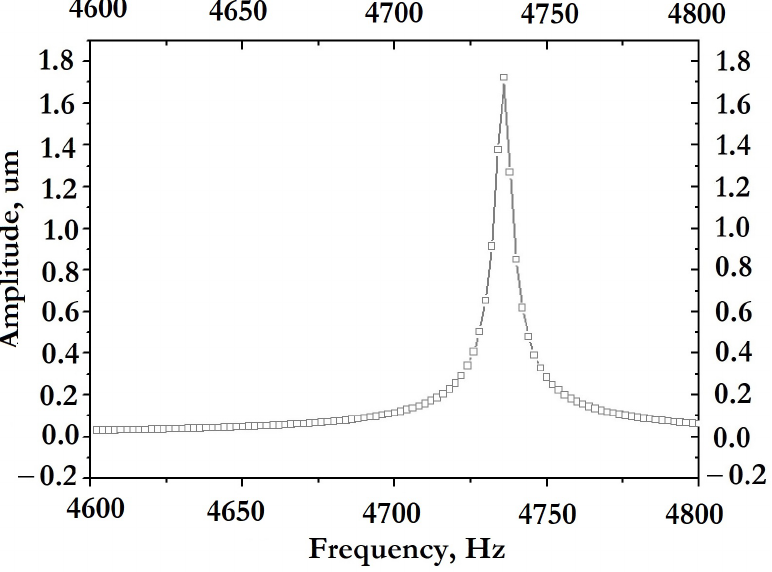
Figure 24. Approximation by the Lorentz method using data from a mathematical experiment on finding the amplitude–frequency response of the